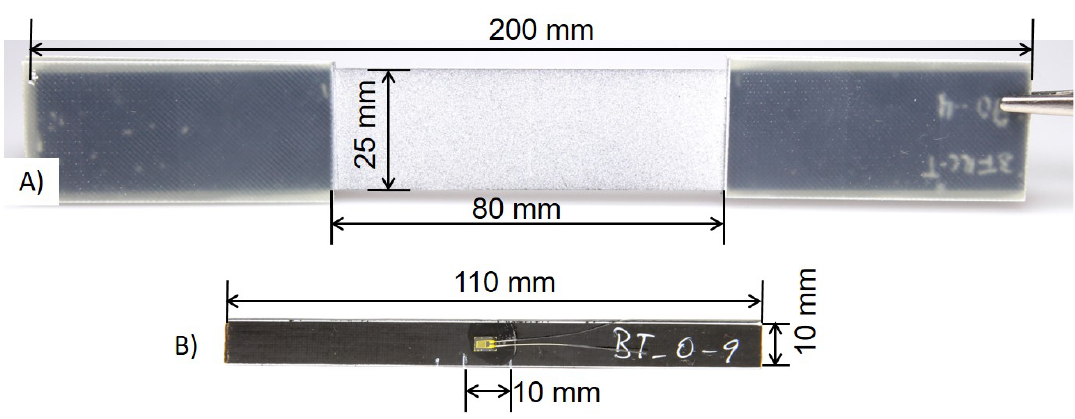
Figure 2. ( A ) For tensile and shear tests, the specimen is placed in the self-locking grips of the Zwick Roell Z100 universal testing machine. A high resolution camera captures the specimens’ deformation for Digital Image Correlation (DIC) evaluation. ( B ) For compressive testing, a specimen support jig is centered under a punch, and strain gauges are employed.